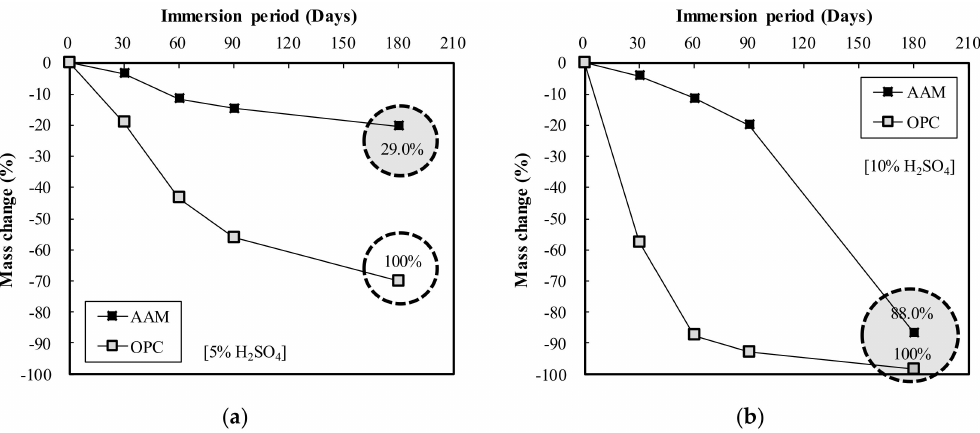
Figure 11. Mass change of OPC and AAC by immersion period: ( a ) 5% H 2 SO 4 ( b ) 10% H 2 SO 4 solution.